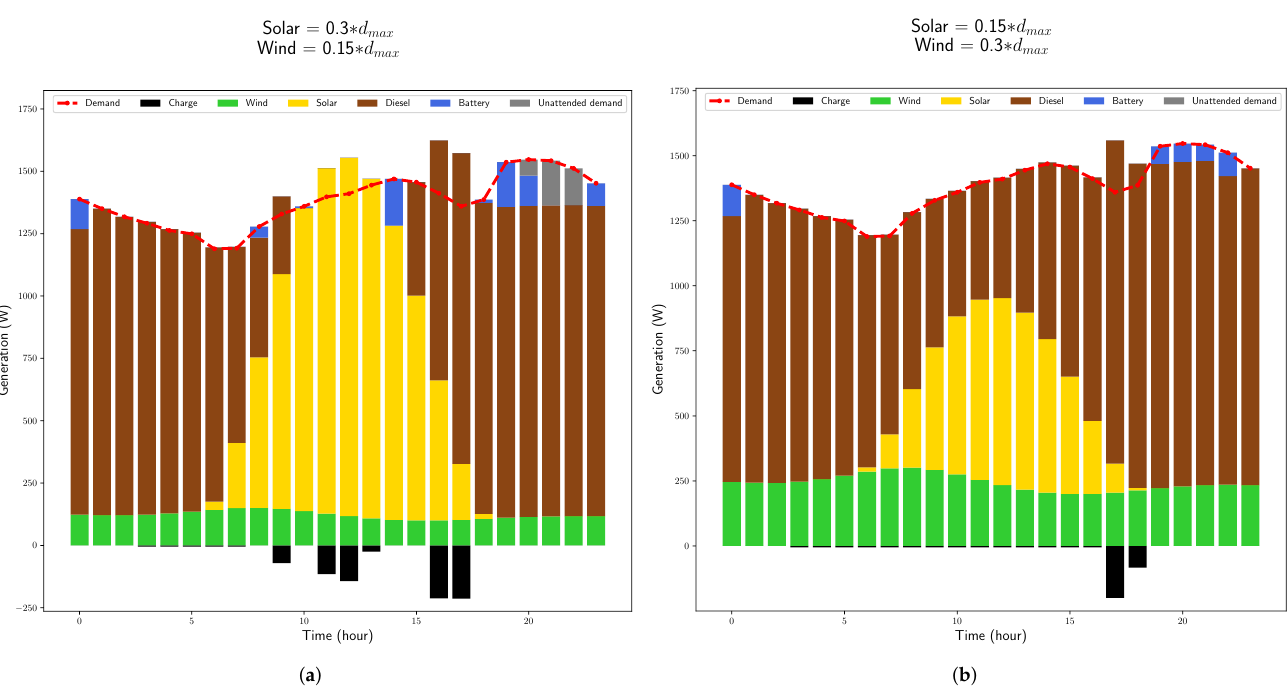
Figure 4. Use of renewable resources for a combined 45% of installed capacity. ( a ) Microgrid load d max and 15% d max of solar and wind installed capacity. ( b ) Microgrid load management for 30% ∗ ∗ d max and 30% d max of solar and wind installed management for 15% ∗ ∗